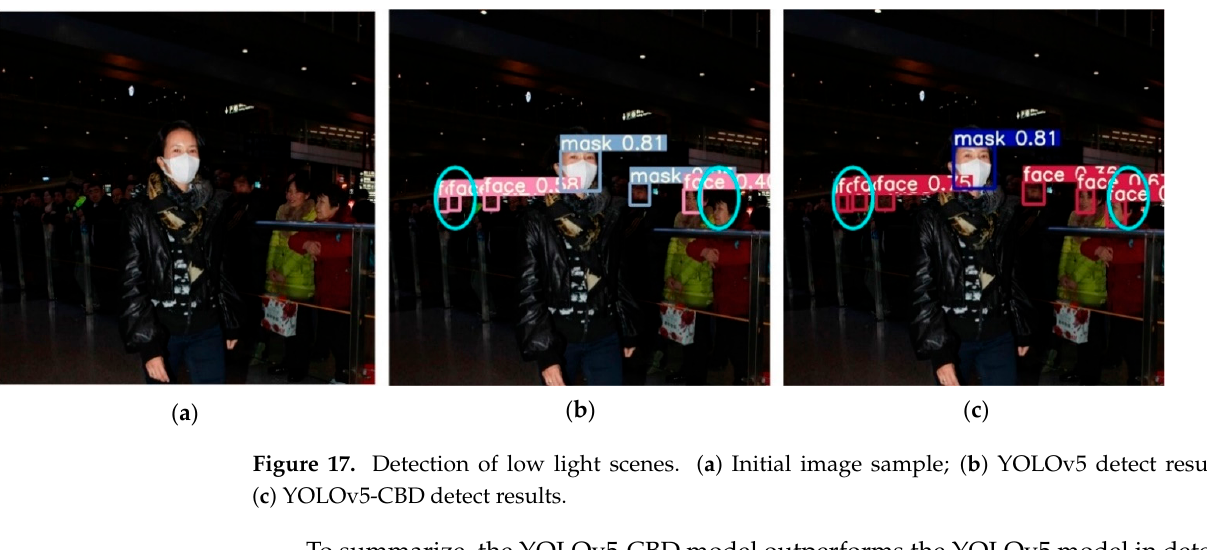
Figure 16. Detection of small targets at long distances. ( a ) Initial image sample; ( b ) YOLOv5 detect results; ( c ) YOLOv5-CBD detect results.